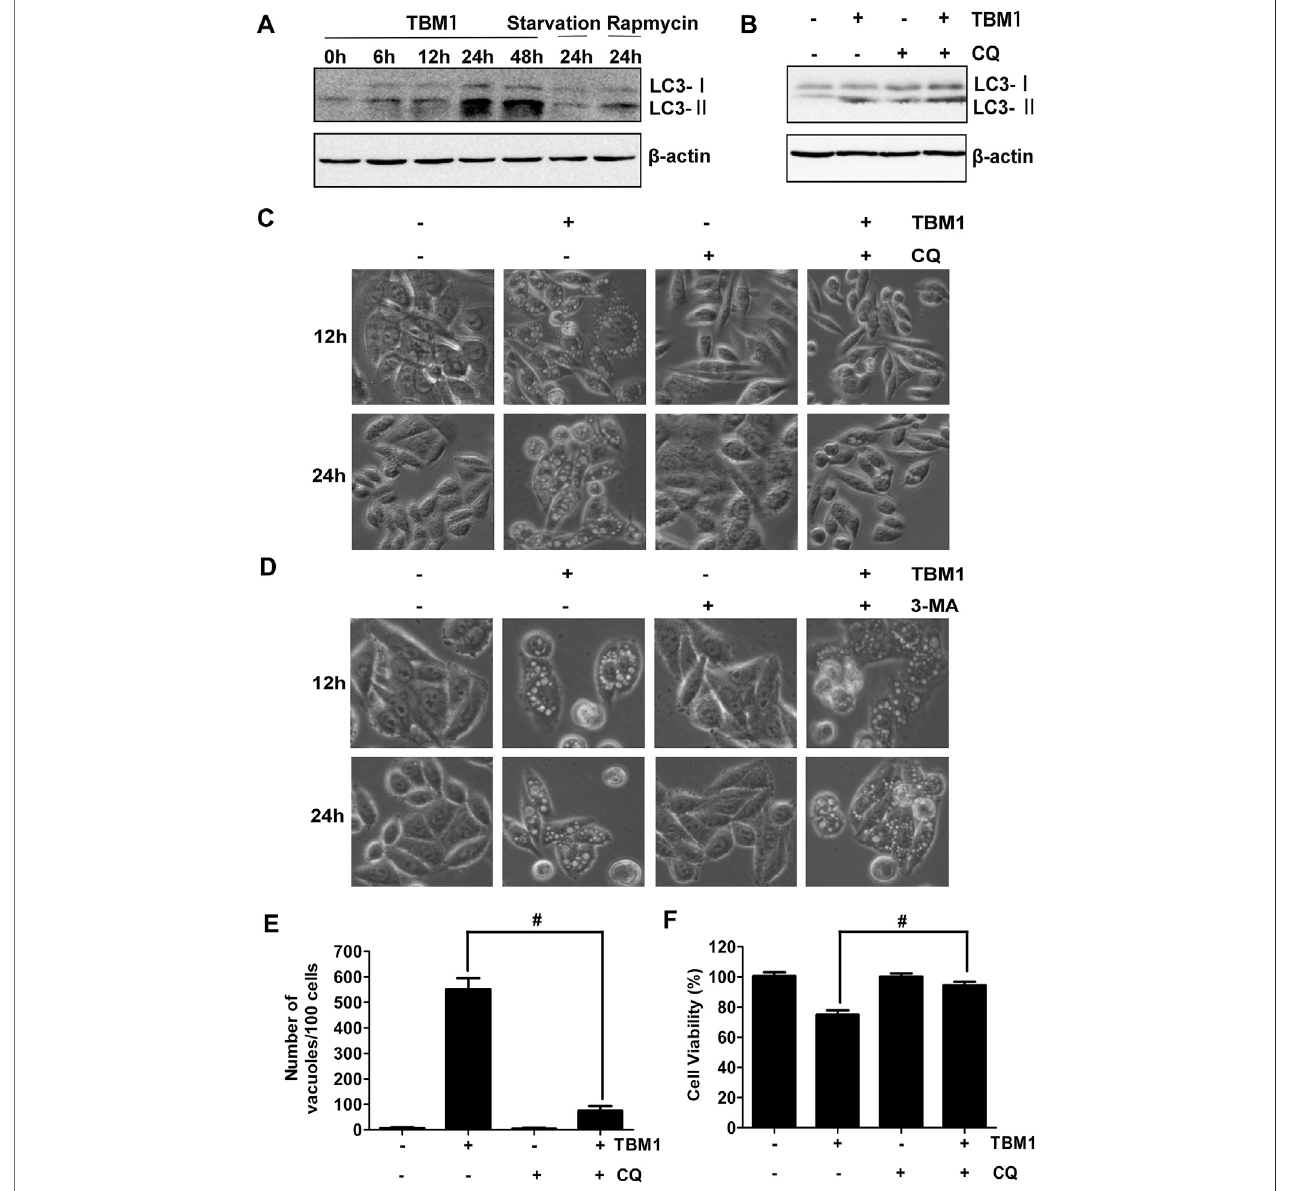
FIGURE6| Chloroquinesuppress TBM1-inducedvacuolation and celldeathinCRC cells. (A) SW480weretreatedwith8 μ MTBM1fordifferenttime orstarvation or 1 μ M rapamycin for 24 h. Protein expression of LC3-I and LC3-II was detected by Western blotting. Beta-actin were served as loading control. (B) SW480 cells were pre-culturedwithorwithoutchloroquine(CQ)(10 μ M)for1 hbeforeexposuretoTBM1for24 h.LC3processingwasassessedusingWesternblottinganalysis. (C) After treatmentwithSW480cellsfordifferenttimeas (B) ,morphologicalchangeswereobservedbyphase-contrastmicroscopy. (D) SW480cellswerepre-culturedwith orwithout3-MA(3 mM)for1 hbeforeexposuretoTBM1fordifferenttime.Morphologicalchangeswereobservedusingphase-contrastmicroscopy. (E) Thenumberof vacuoles of the same cultures as (B) for 48 h was counted from three different imagines. (F) Cell viability was measured by MTT assay ( n (cid:1) 5). # p < 0.01.